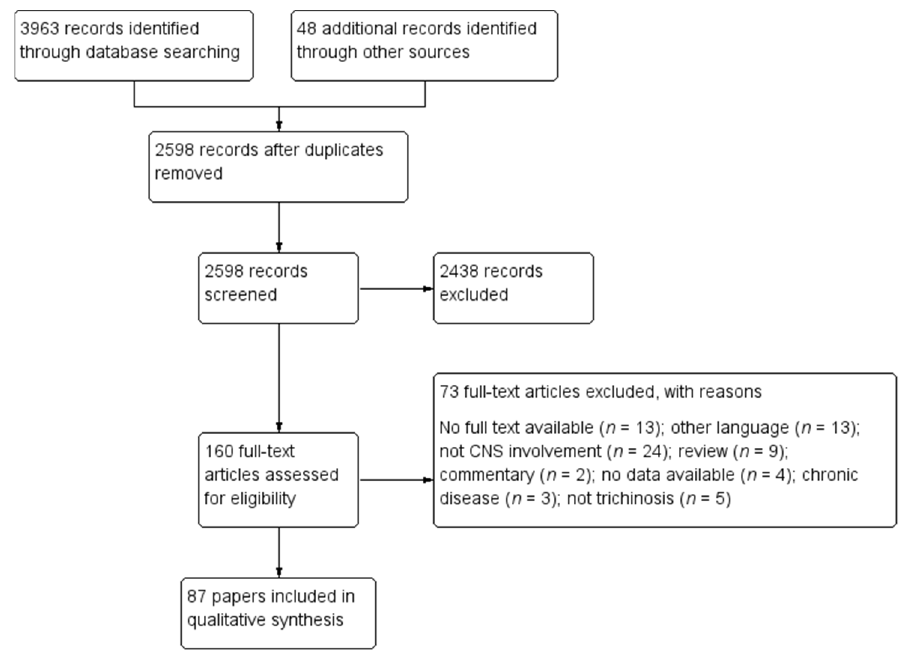
Figure 1. Study selection flowchart.